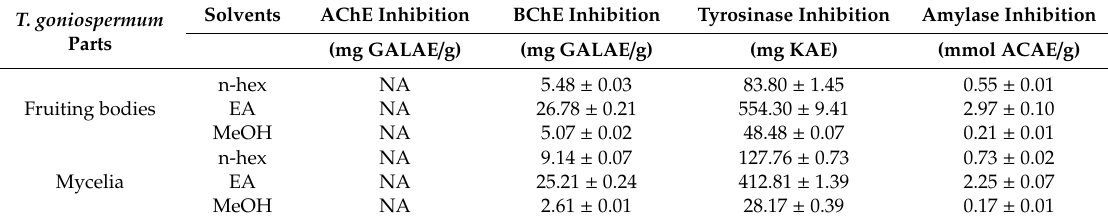
Table 3. Enzyme inhibitory e ff ects of the tested